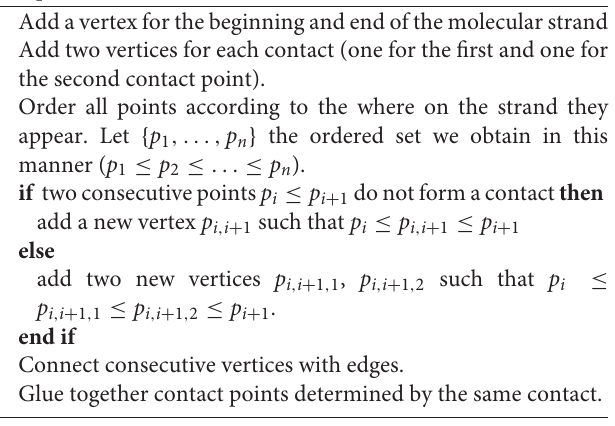
Algorithm 1 Representing a linear molecule as a simplicial